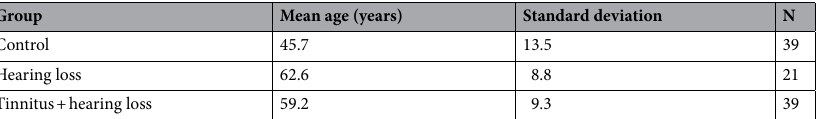
Table 1. Demographics of participants. The hearing loss groups, with and without tinnitus, did not differ with respect to age (p = 0.419). The control group was significantly younger than both hearing loss groups, with and without tinnitus (p <